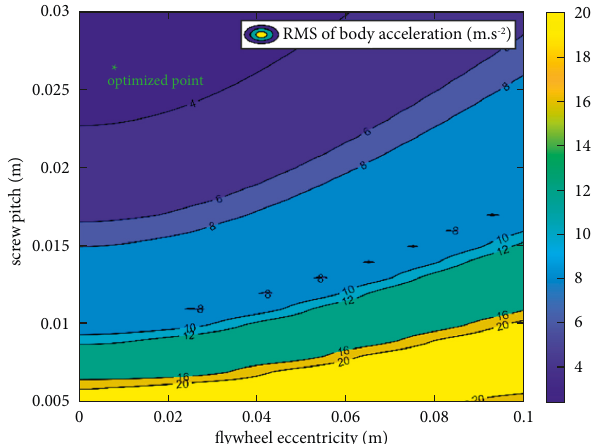
Figure 14: The change of body acceleration subject to the change of flywheel and screw pitch in the parallel